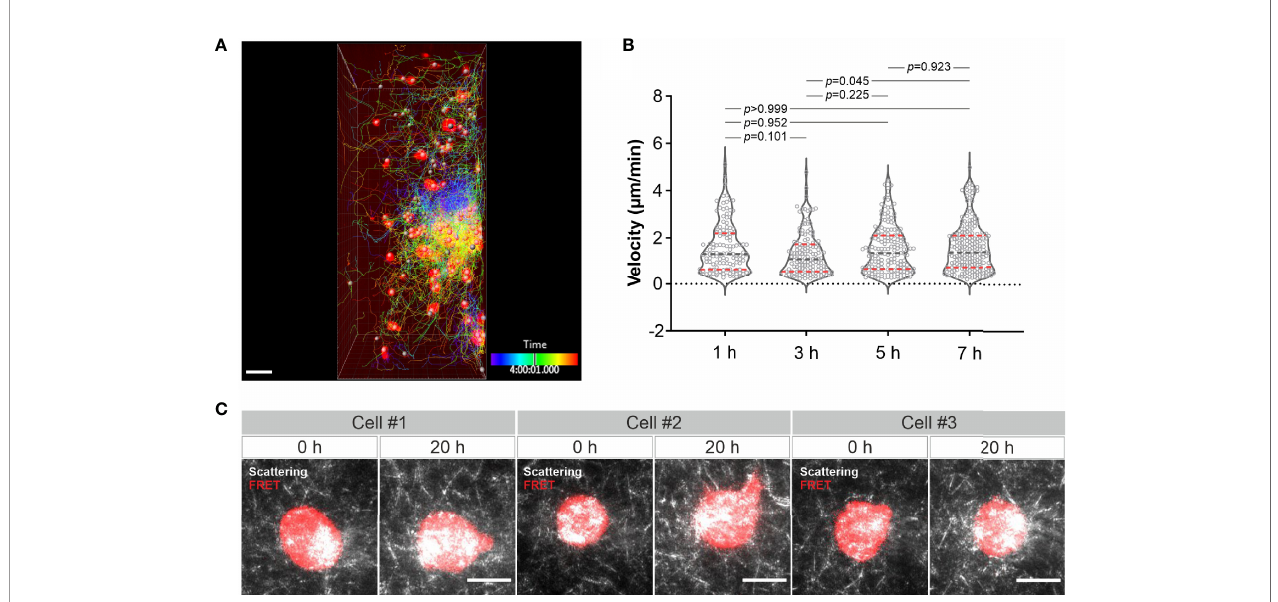
FIGURE 4 | Long-term visualization of cell-ECM interaction. (A) T cell migration in long-term visualization. Calcein-AM red-orange loaded primary human CD4 + T cells were embedded in the collagen matrices (Bovine collagen, 2 mg/ml). Z-stacks with step-size of 2 µm for 98 slices were obtained using LSSM and fl uorescence modality concurrently at 37°C every 3 min for 10 hours. A drift correction was performed. T cells were automatically tracked. A maximum intensity projection (MIP) of all the 98 slices is shown. Scale bars are 40 µm. (B) Quanti fi cation of T cell velocity. To analyze cell velocity, T cells in fi ve frames before and after each time point were tracked and the mean velocity during this time (30 min) was calculated. For time point 1h, 3h, 5h and 7h, 127 cells, 144 cells, 167 cells and 214 cells were analyzed. Multiple comparisons in ordinary one-way ANOVA was used for p values. Gray dashed lines are the median. Red dashed lines are the ends of the fi rst and third quartiles. (C) K562 cells stably expressing pCasper was embedded in the collagen matrices (Bovine collagen, 2 mg/ml). Z-stacks with step-size of 2 µm for 75 slices were obtained using LSSM and FRET fl uorescence modality simultaneously at 37°C every 5 min for 20 hours. A maximum intensity projection (MIP) from three exemplary cells is shown. Scale bars are 10